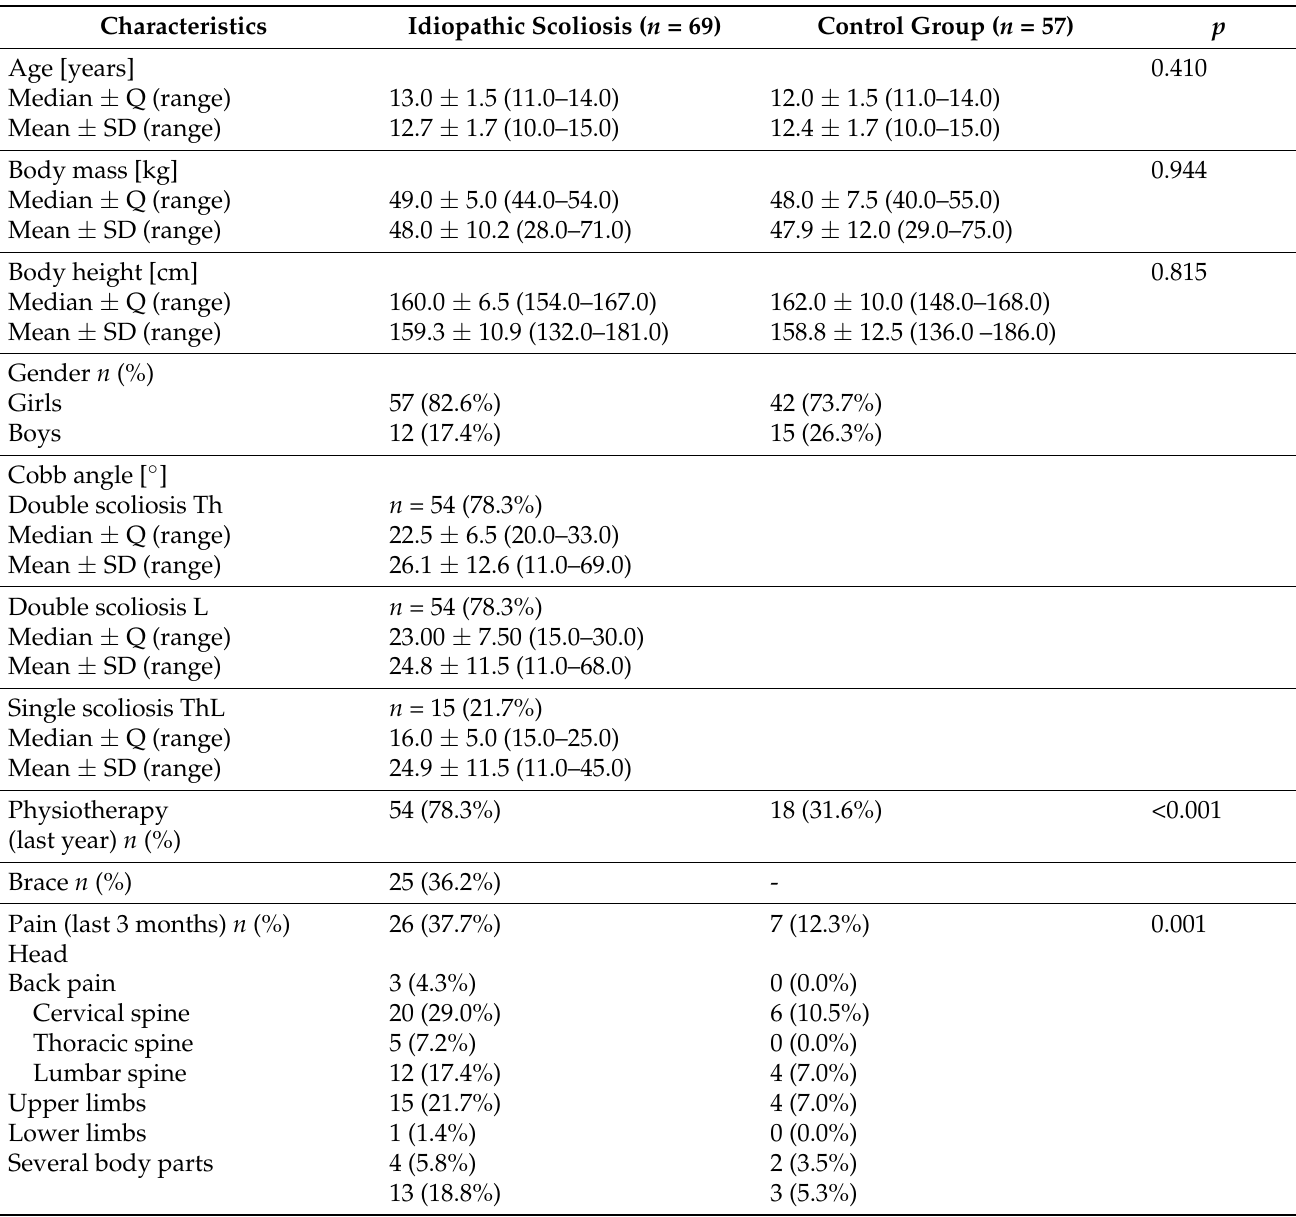
Table 1. Characteristics of adolescents with idiopathic scoliosis (IS) and the control group